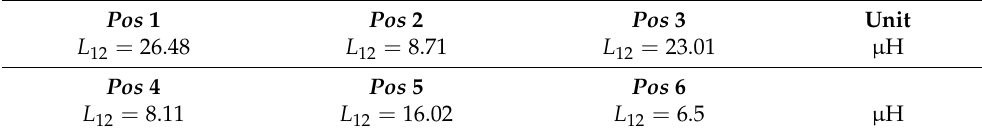
Table 4. Estimation results of L 12 in all six Pos for N 1 = 8 and N 2 = 10. Pos 1 Pos 2 Pos 3 Unit L 12 = 26.48 L 12 = 8.71 L 12 = 23.01 µ H Pos 4 Pos 5 Pos 6 L 12 = 8.11 L 12 = 16.02 L 12 = 6.5 µ H Step 2 of the fitting approach method characterizes L 12 = f ( airgap , l t ) using the values found in Step 1 for a particular set of turns. The estimated results of L 12 for N 1 = 8 and N 2 = 10, listed in Table 4, are used as an example to validate Step 2 of the proposed approach in detail. First, L 12 is characterized as a function of the airgap for Pos with the same l t . The L 12 results for Pos 1 and Pos 2, identified in Table 4, are inserted in a curve- fitting tool to discover the constant values in (7). In this particular case, the x vector used in fitting tool is equal to [ 100, 250 ] , whereas the y vector is equal to [ 26.48 × 10 − 6 , 8.71 × 10 − 6 ] . The same approach is carried out for the L 12 pair results ( Pos 3, Pos 4) and ( Pos 5, Pos 6), and they are defined